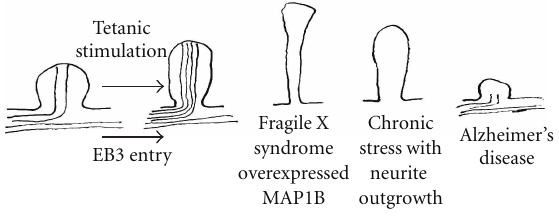
Figure 4: Spine shape change. Hypothesis for the induction of synapse loss and spine loss in Alzheimer’s disease due to the depoly- merization of intraspinal